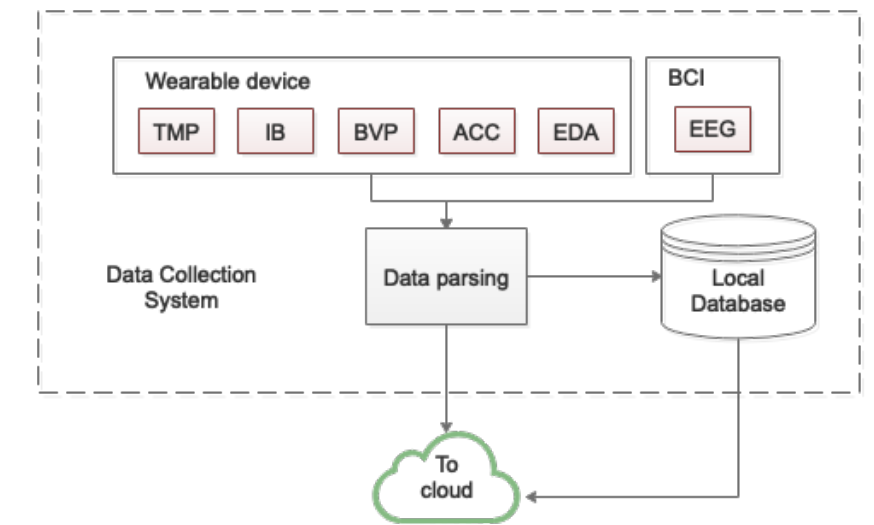
Figure 3. Diagram of “Data Management